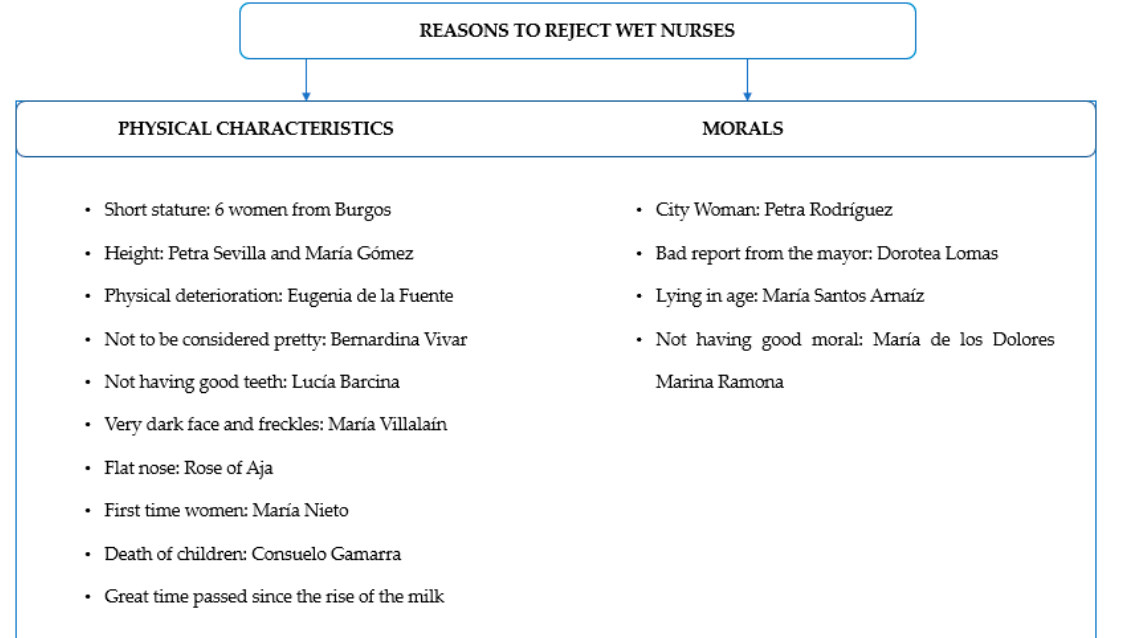
Figure 2. Reasons to reject wet nurses. Source: authors’ own elaboration.